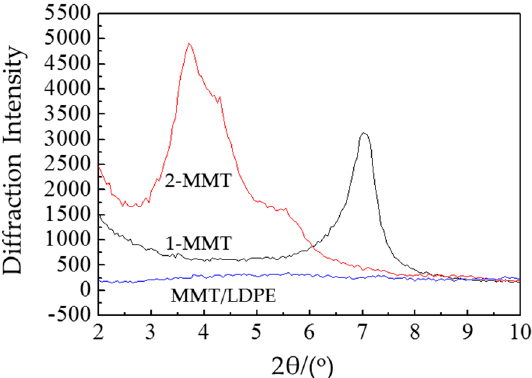
Figure 4. XRD patterns of MMT and methylcyclopentadienyl manganese tricarbonyl/low density